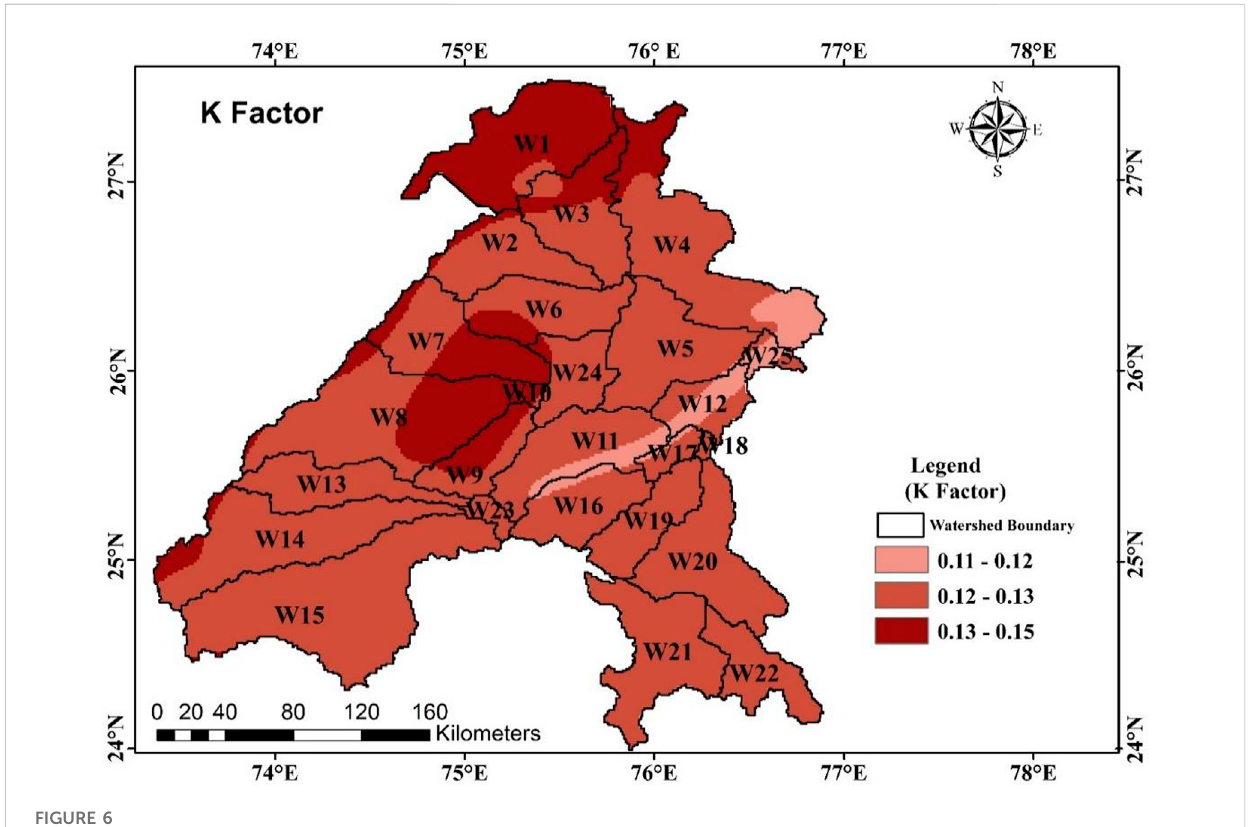
K factor map of the study